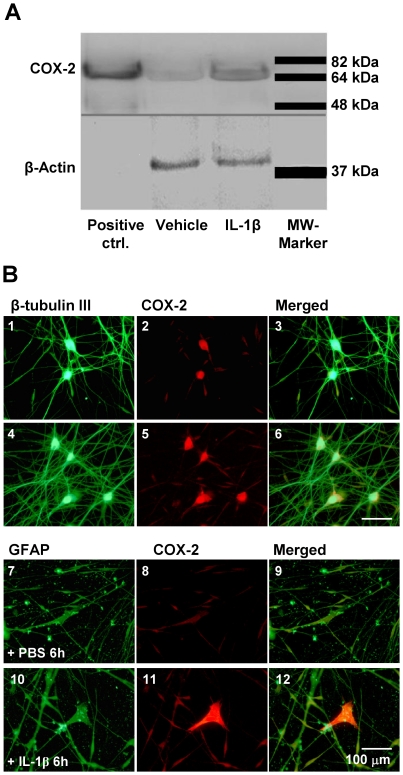
Expression of COX-2 protein in trigeminal ganglia cells after IL-1β stimulation.COX-2 protein in cell culture homogenates was analyzed 6 hours after stimulation with IL-1β using Western blot (n = 3). A representative image is shown in panel A. Cell lysate of IL-1β treated TGC and the positive control (IFNy/LPS treated macrophages) showed a clear band at 70 kDa corresponding to COX-2 protein. Vehicle stimulation resulted in a faint COX-2 expression. The expression of COX-2 protein in cultured trigeminal ganglia cells exposed 6 hours to vehicle (10 ng/ml, upper panel B1-B3/B7-B9) or IL-1β (0.1 M PBS, lower panel B4-B9/B10-B12) is shown in fluorescent micrographs in panel B. Cells were stained with a mouse β-tubulin III antibody, indicative of neuronal cells (B1 and B4) or a mouse GFAP antibody, indicative of glial cells (B7 and B10), and a rabbit COX-2 antibody (B2, B5, B8, B11). The β-tubulin III and the GFAP antibodies were recognized by an Alexa Fluor 488 labeled secondary donkey anti-mouse antibody (green) and the COX-2 antibody was recognized by an Alexa Fluor 594 labeled secondary donkey anti-rabbit antibody (red). Double stained cells appear orange in B3, B6, B9 and B12. IL-1β caused a clear upregulation of COX-2 in neuronal and glial cells (lower panel) whereas a faint COX-2 expression could also be observed in control experiments (upper panel). The strongest induction of COX-2 was seen in bigger glial cells (40-100 µm) and neuronal cells.